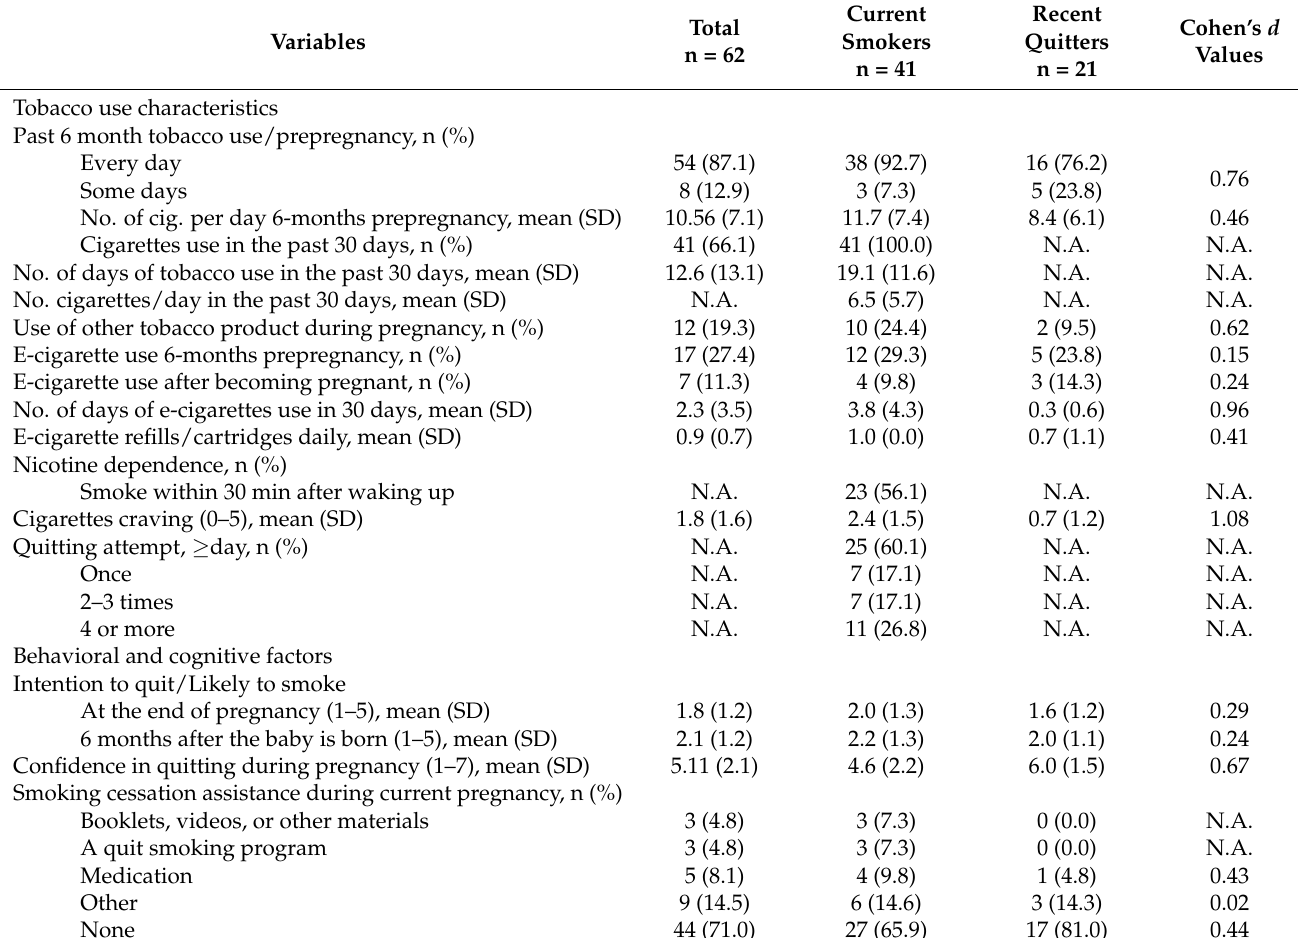
Table 3. Tobacco-related characteristics among pregnant women from obstetric and family practice clinics in US